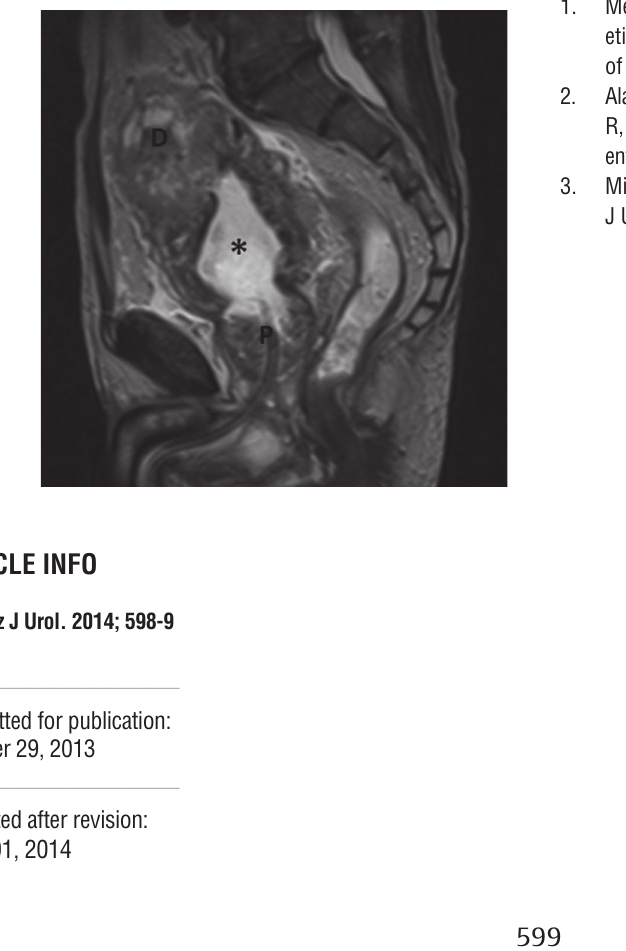
Figure 3 - Sagittal T2 weighted image shows diverticulum (D) and bladder (asterisk). P: